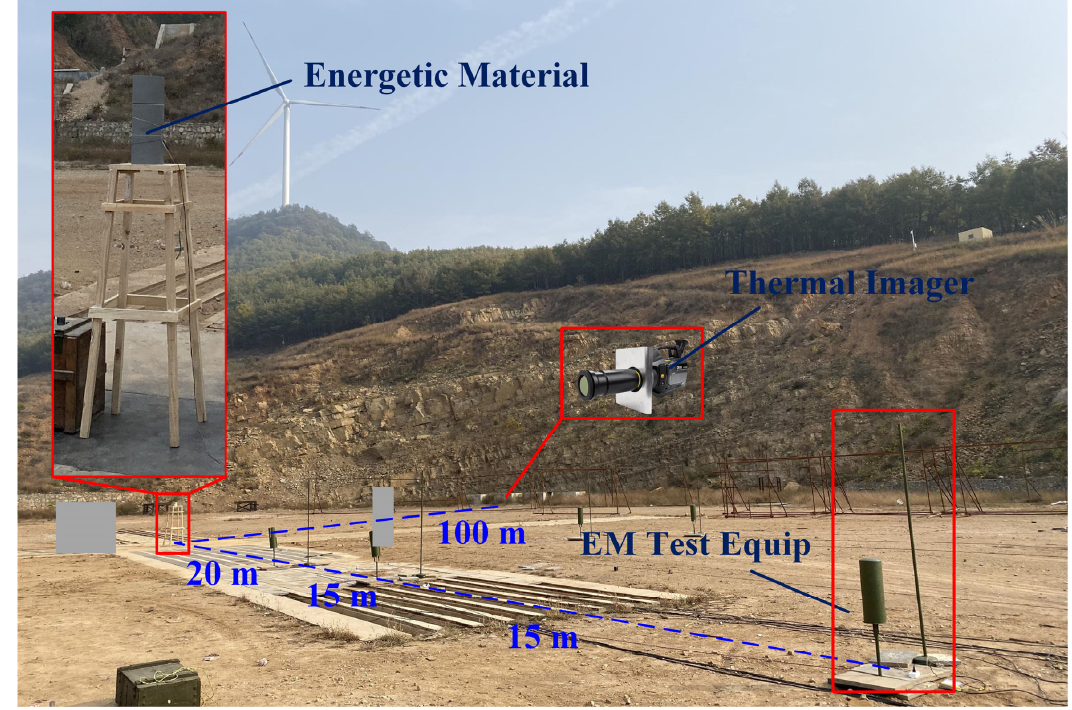
Figure 3. Experimental field and